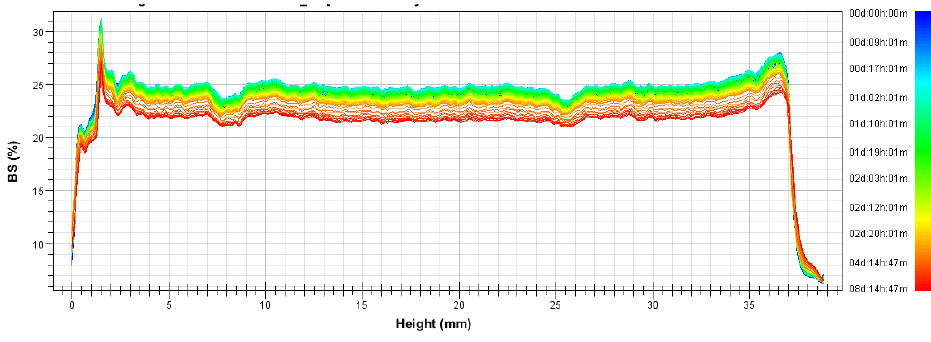
Figure 8. Backscattering profiles of transfersomes formulated with and without VitD 3 encapsulated. Zeta potential of all loaded and non-loaded samples was measured, but due to the non-ionic character of the surfactants used, all the systems presented lower negative values. Values between −2.8 and −5.4 mV were registered in all cases. However, sample A1 presented a higher absolute value, −18.5 and −21.5 mVfor empty and VitD3 encapsulated into the vesicular membrane, respectively. This